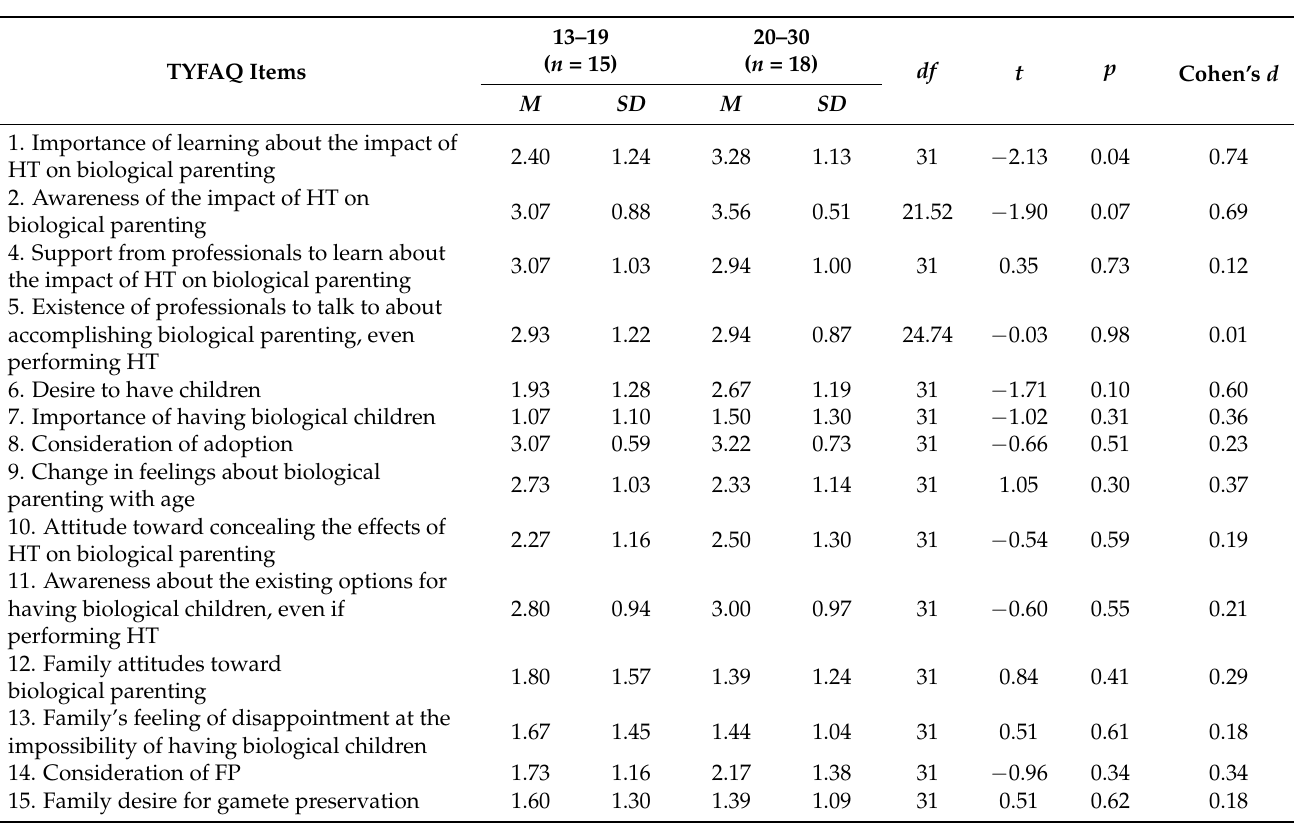
Table 4. Differences in Attitudes Towards Parenthood and Fertility Preservation between Younger